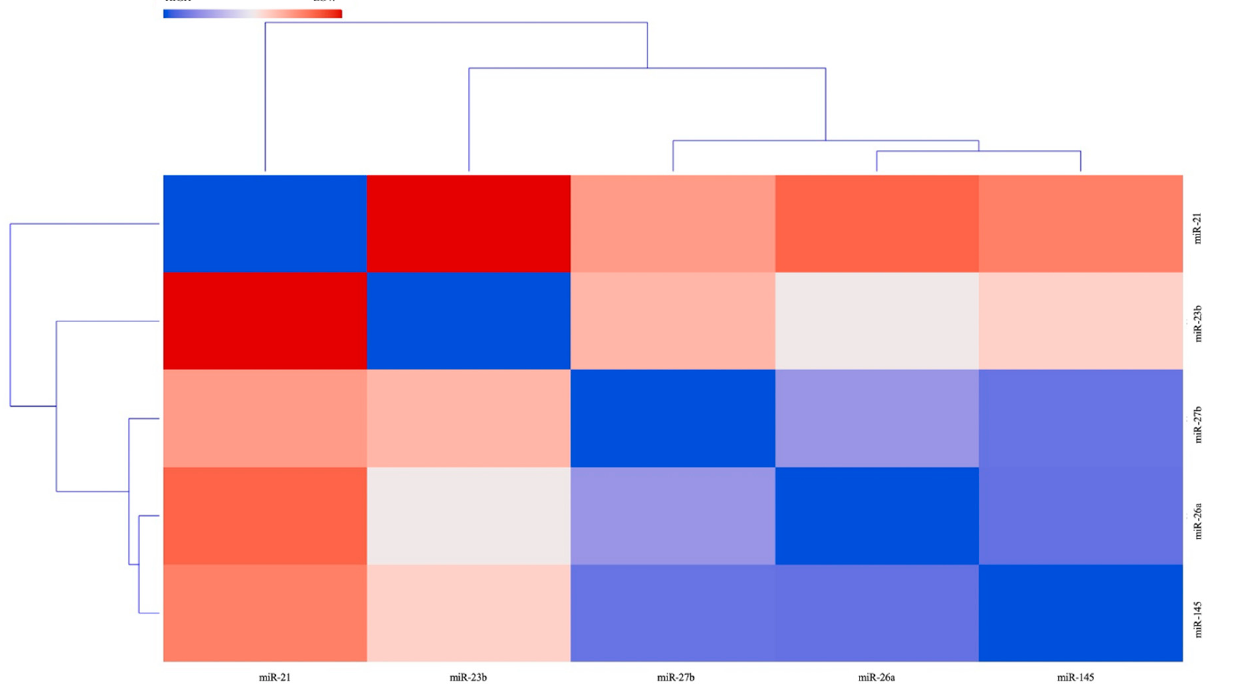
Figure 3. Heat map of miRNAs expression in condition of moderate continuous hypoxia (2% O2). The heatmap shows the similarities between the expression profiles of the significantly changed miRNAs in condition of moderate continuous hypoxia. Blue color represents lower than mean intensity and red indicates higher than mean intensity. Each row and each column represent a miRNA.